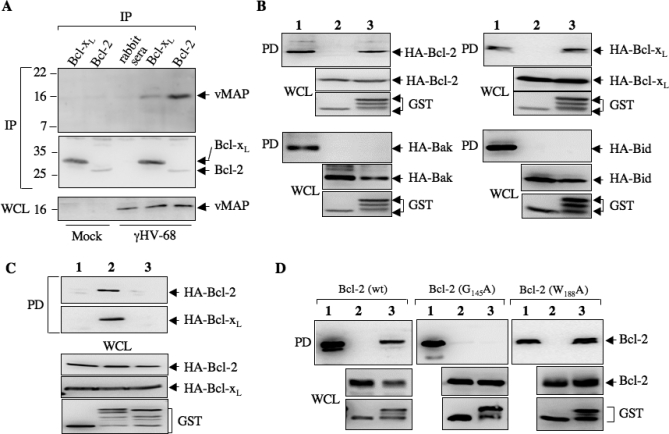
vMAP Interacts with Bcl-2/Bcl-xL
(A) vMAP interacts with Bcl-2/Bcl-xL in γHV-68-infected cells. At 16 h post-infection, γHV-68-infected (MOI = 1) or mock-infected NIH3T3 cells were harvested and post-centrifuge supernatants were subjected to immunoprecipitation (IP) with rabbit antibodies to Bcl-2 or Bcl-xL, followed by immunoblotting with anti-vMAP serum. A normal rabbit serum was included as a negative control. Protein precipitates were analyzed by immunoblotting with antibodies to Bcl-2 and Bcl-xL (middle panel). Whole cell lysates (WCL) of mock-infected or γHV-68-infected NIH3T3 cells were immunoblotted with anti-vMAP serum (bottom panel).(B) The N-terminal sequence of vMAP interacts with Bcl-2/Bcl-xL but not with Bak and Bid. At 48 h post-transfection with a plasmid expressing HA-Bcl-2, HA-Bcl-xL, HA-Bak, or HA-Bid, and a plasmid expressing GST (lane 2) or vMAP(1–50)-GST (lane 3), cell lysates of 293T were used for GST pull-down (PD) assay, followed by immunoblotting with anti-HA (top panel of each set). WCLs were analyzed by immunoblotting with antibodies to HA epitope (Bcl-2 family proteins, middle panels) and GST (bottom panels) for GST or vMAP(1–50)-GST expression. Lane 1 is 2% input of lysates of cells expressing GST and Bcl-2 family proteins. For all four sets of PDs (top panel), lane 1 shows the equivalent amount of Bcl-2 family proteins compared to those shown in the middle panel.(C) The first 20 amino acids of vMAP are essential for its interaction with Bcl-2/Bcl-xL. 293T cells were transfected with a plasmid expressing HA-Bcl-2, HA-Bcl-xL together with a plasmid expressing GST (lane 1), vMAP-GST (lane 2), or vMAPΔ20-GST (lane 3). Mammalian GST pull-down was carried out as described in (B). The precipitates were analyzed by immunoblotting with anti-HA to detect Bcl-2 and Bcl-xL (top two panels). WCLs were analyzed by immunoblotting with anti-HA and anti-GST antibodies to demonstrate the expression of Bcl-2/Bcl-xL and GST fusion, respectively.(D) The Bcl-2 BH2 domain is not involved in vMAP binding. At 48 h post-transfection with a plasmid expressing HA-Bcl-2, Bcl-2 G145A, or Bcl-2 W188A together with a plasmid expressing GST (lane 2) or vMAP(1–50)-GST (lane 3), 293T cell lysates were used for GST pull-down, followed by immunoblotting with Bcl-2 antibody (top panel of each set). WCLs were analyzed by immunoblotting with antibodies to Bcl-2 (middle panel) and GST (bottom panel). Lane 1 indicates 2% input of lysates of cells expressing vMAP-GST and Bcl-2/Bcl-xL.